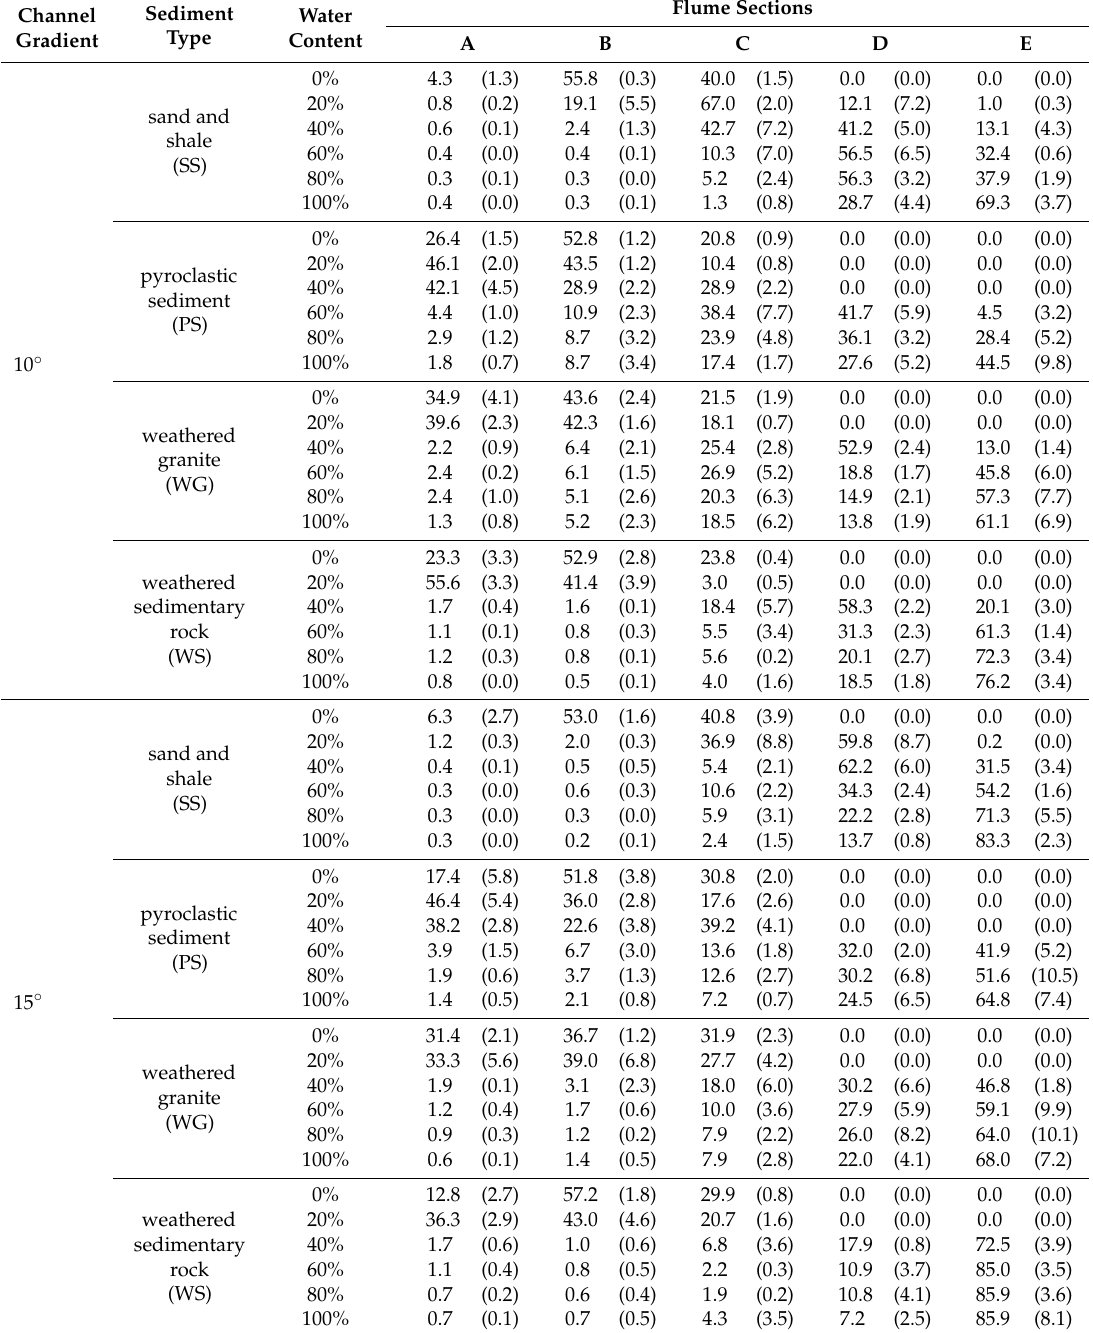
Table A1. Summary of sediment deposition for 0 ◦ inflow angle (in %). Values in parentheses indicate standard